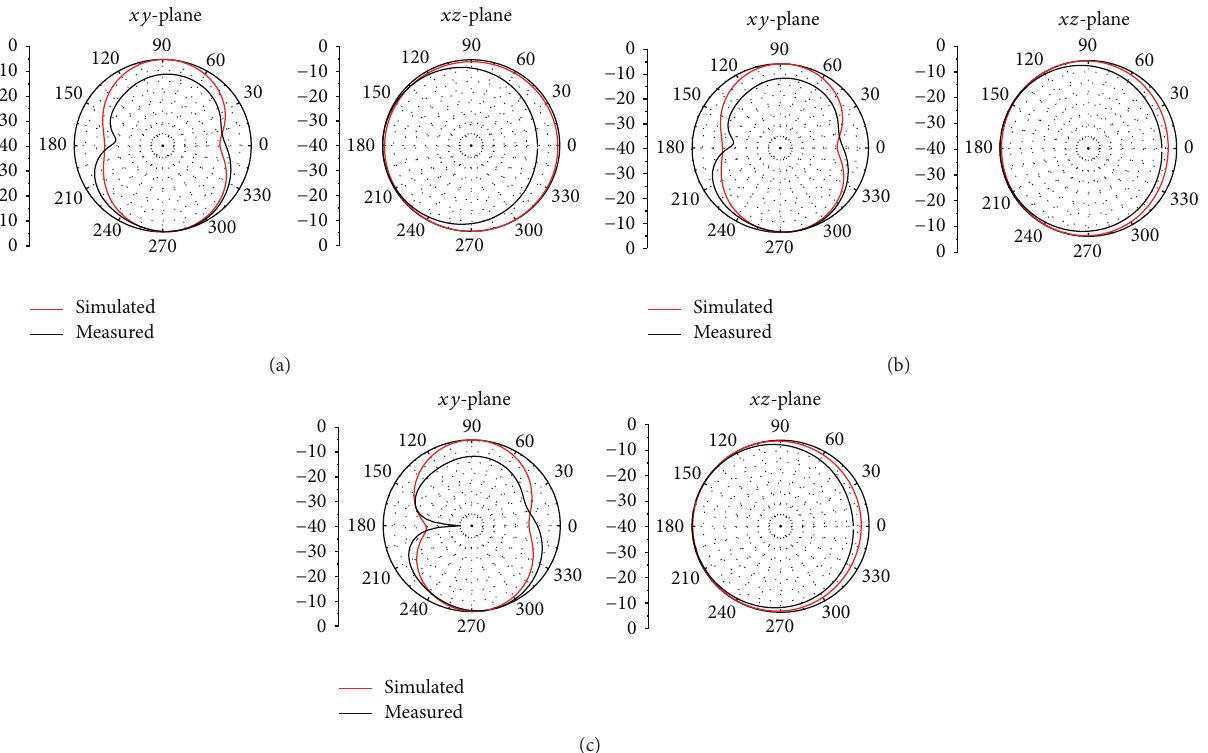
Figure 9: Simulated and measured normalized radiation patterns for the proposed antenna at (a) 1.76 GHz, (b) 5.2 GHz, and (c) 5.8 GHz.